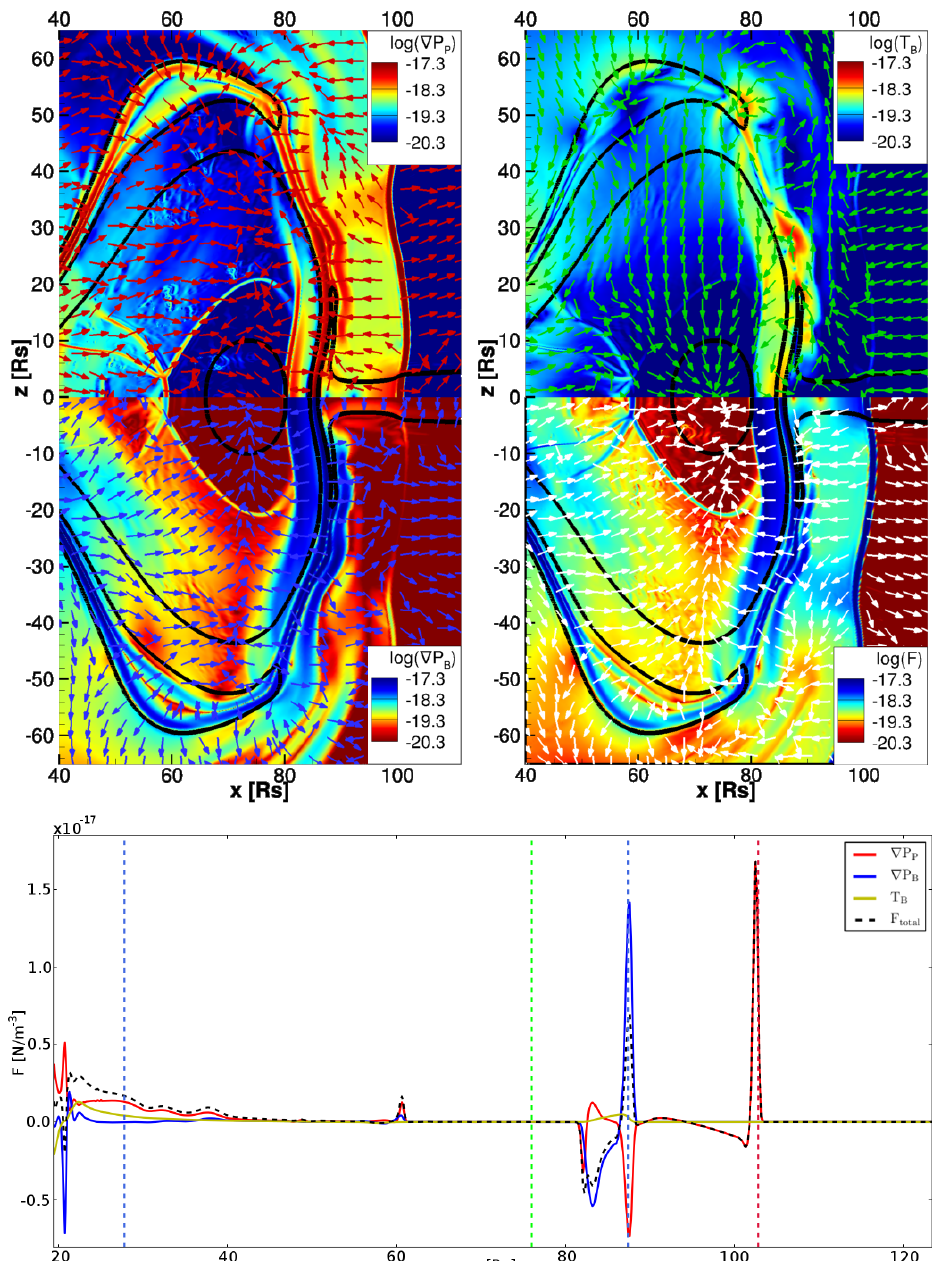
Figure 3. Same as Figure 2 but 20 h after